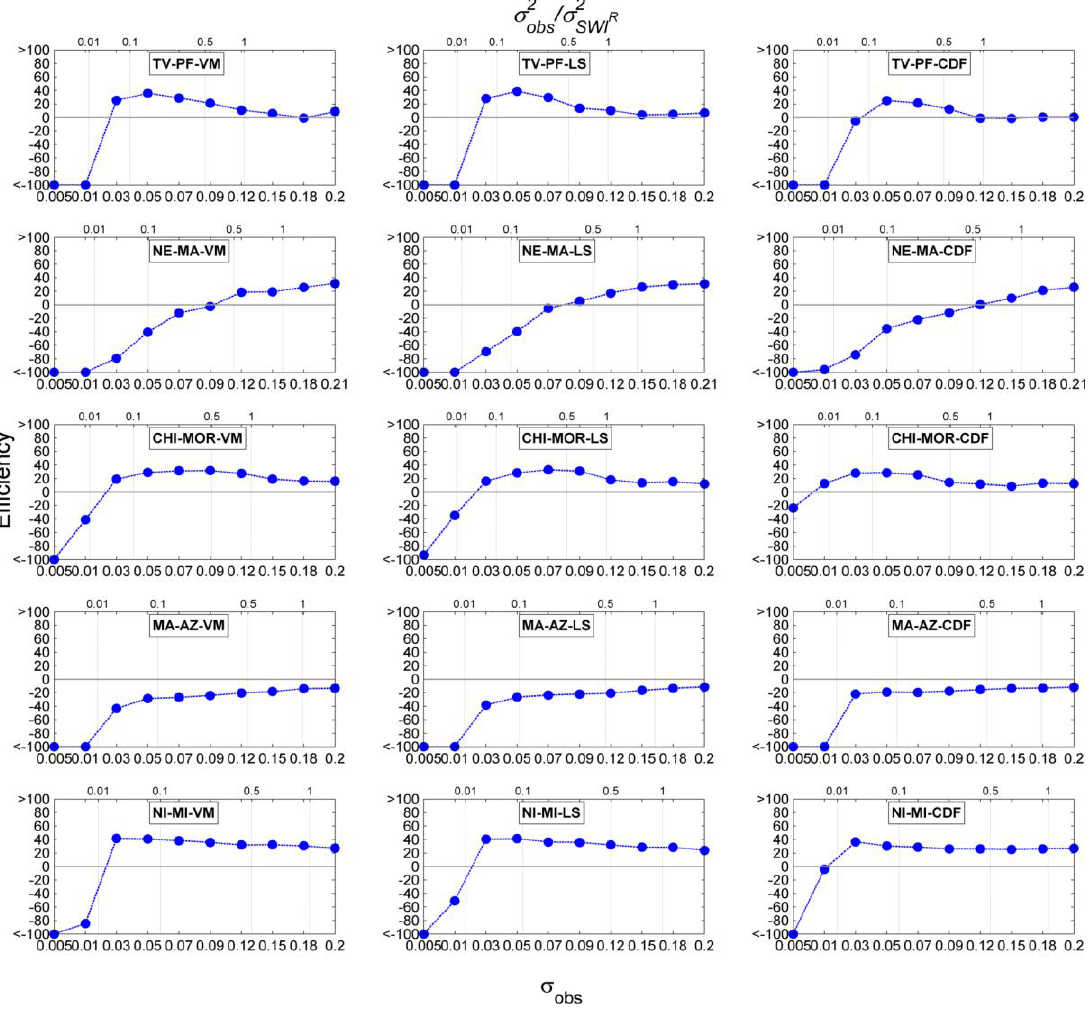
Figure 4. Efficiency index calculated with respect to the open loop simulation for the five catchments for the three RTs as a function of the observation error. σ obs is the observation  is the variance observation error, 2 error standard deviation, 2  is the variance of the obs R SWI rescaled observation. Values below zero (black line) denote a deterioration of the